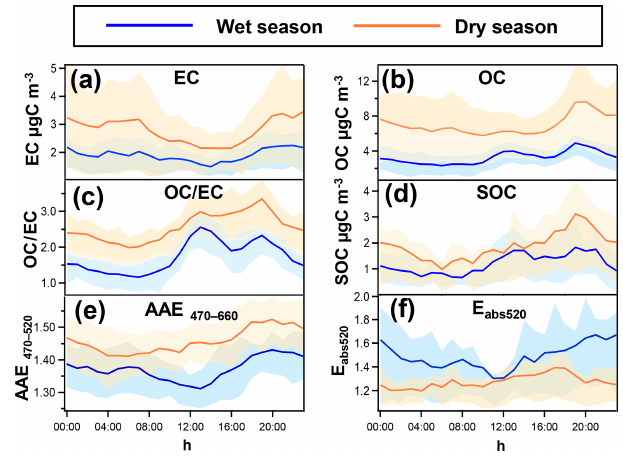
Figure 3. Diurnal pattern carbonaceous aerosols in the wet and dry seasons. The solid lines represent hourly averages and the shaded ar- eas represent 25th and 75th percentiles. (a) EC. (b) OC. (c) OC / EC ratio. (d) SOC. (e) AAE 470–660 . (f) E abs520